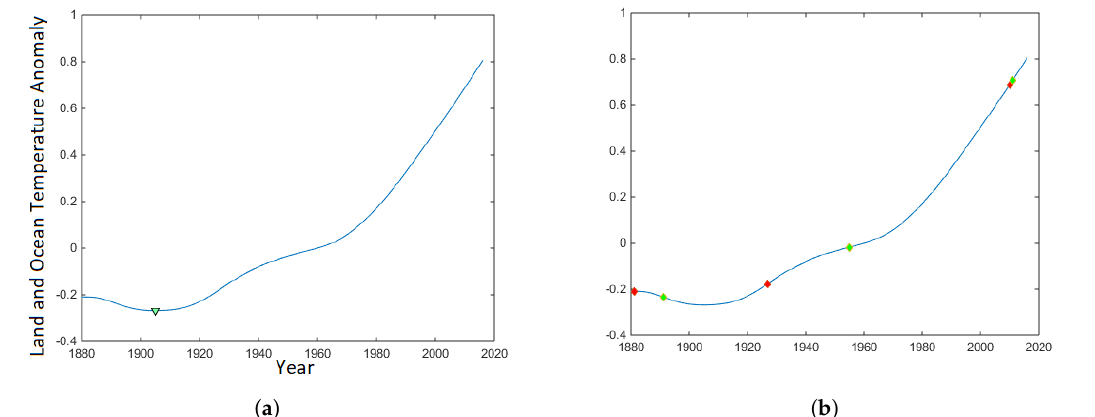
Figure 4. Land and Ocean Temperature: ( a ) Detected peaks in the Land and Ocean Temperature anomalies (Y axis) between 1880 and 2017 (X axis); ( b ) Identified inflection points in the Land and Ocean anomalies (Y axis) between 1880 and 2017 (X axis). Positive inflection point (red diamond); negative inflection point (green